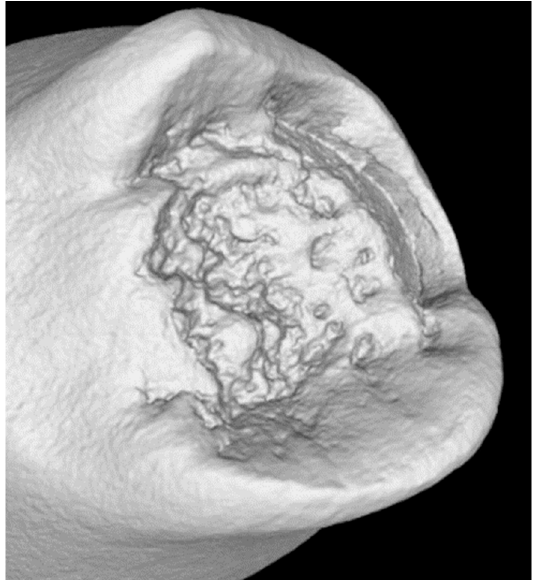
Figure 3. Guide cross section ( a ) and CT scan ( b ).